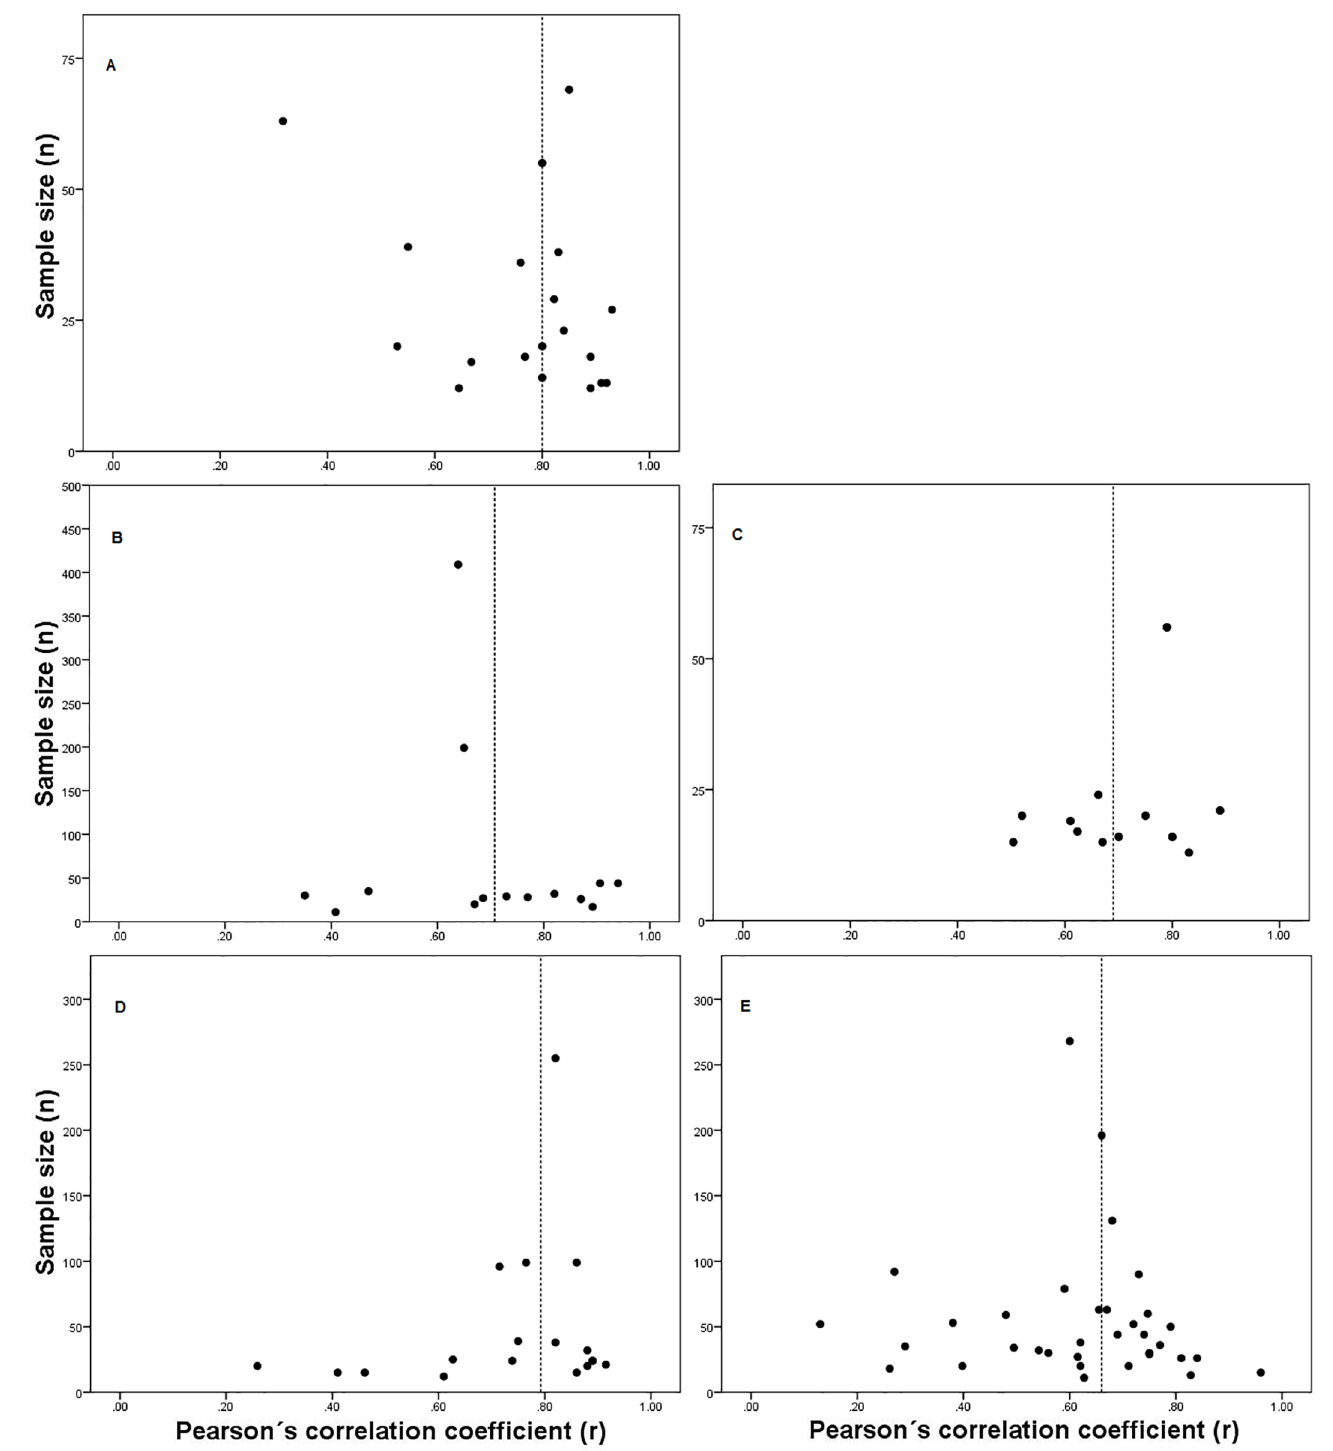
Fig 2. Scatter plot of sample size against criterion-related validity coefficients ( r ) of distance-based walk/run tests for estimating maximal oxygen uptake: (a) 5,000 m walk/run test; (b) 2 miles walk/run test; (c) 3,000 m walk/run test; (d) 1.5 mile walk/run test; and (e) 1 mile walk/run test. Dashed line represents median values of validity